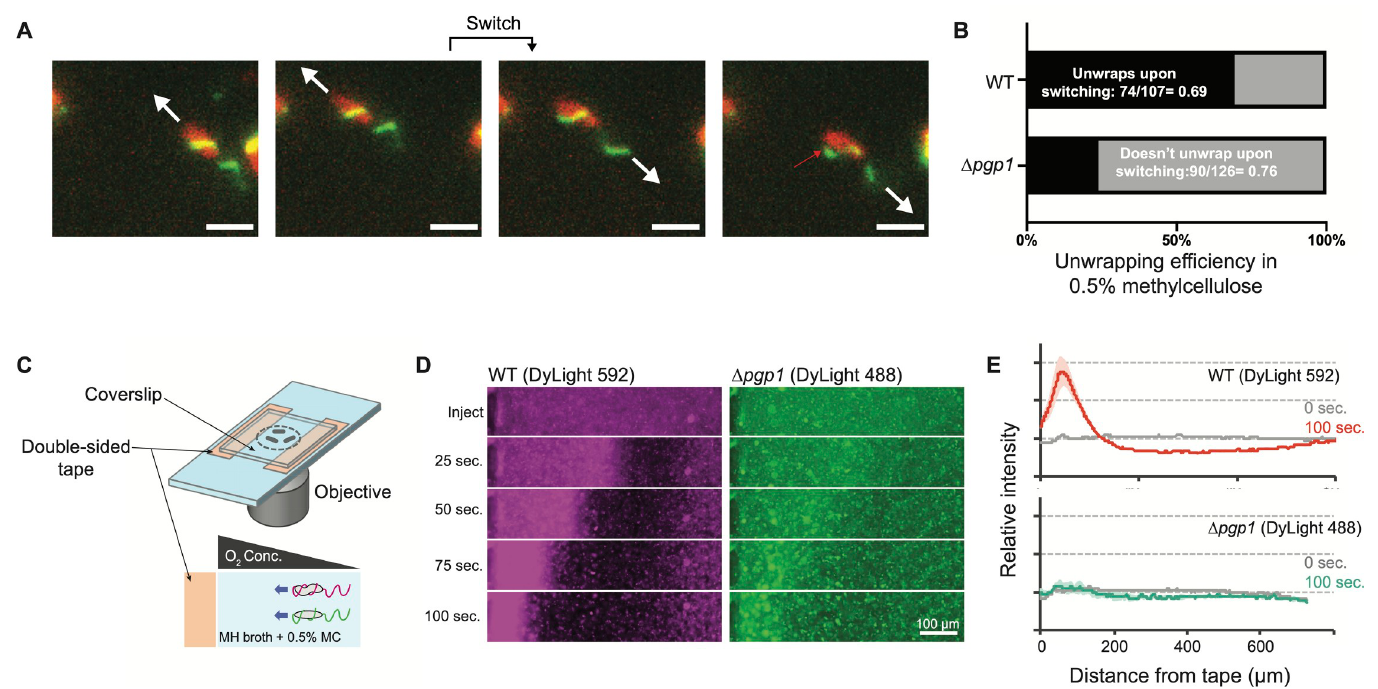
Fig 4. Unwrapping efficiency and chemotactic ability are impaired in straight cells. Switching of motor rotation from CCW to CW usually results in filament unwrapping in the WT, but not in straight cells. During reversals, the wrapped filament of Δ pgp1 cells will often peel away from the cell body, but fail to fully unwrap (red arrow) ( A ). In the straight cell background, filament unwrapping upon switching only occurs 26% of the time, compared to 69% in helical cells ( B ). An aerotaxis competition ( C ) between WT and Δ pgp1 cells revealed that, in addition to reaching the O 2 -rich border (double-sided tape) first, the WT also formed a high density, persisting swarm at the border that left few stragglers behind ( D and E ). Scale bars in A equal to 2 μ m. Fluorescence intensity signals in E are the average of three replicate experiments for each mutant.